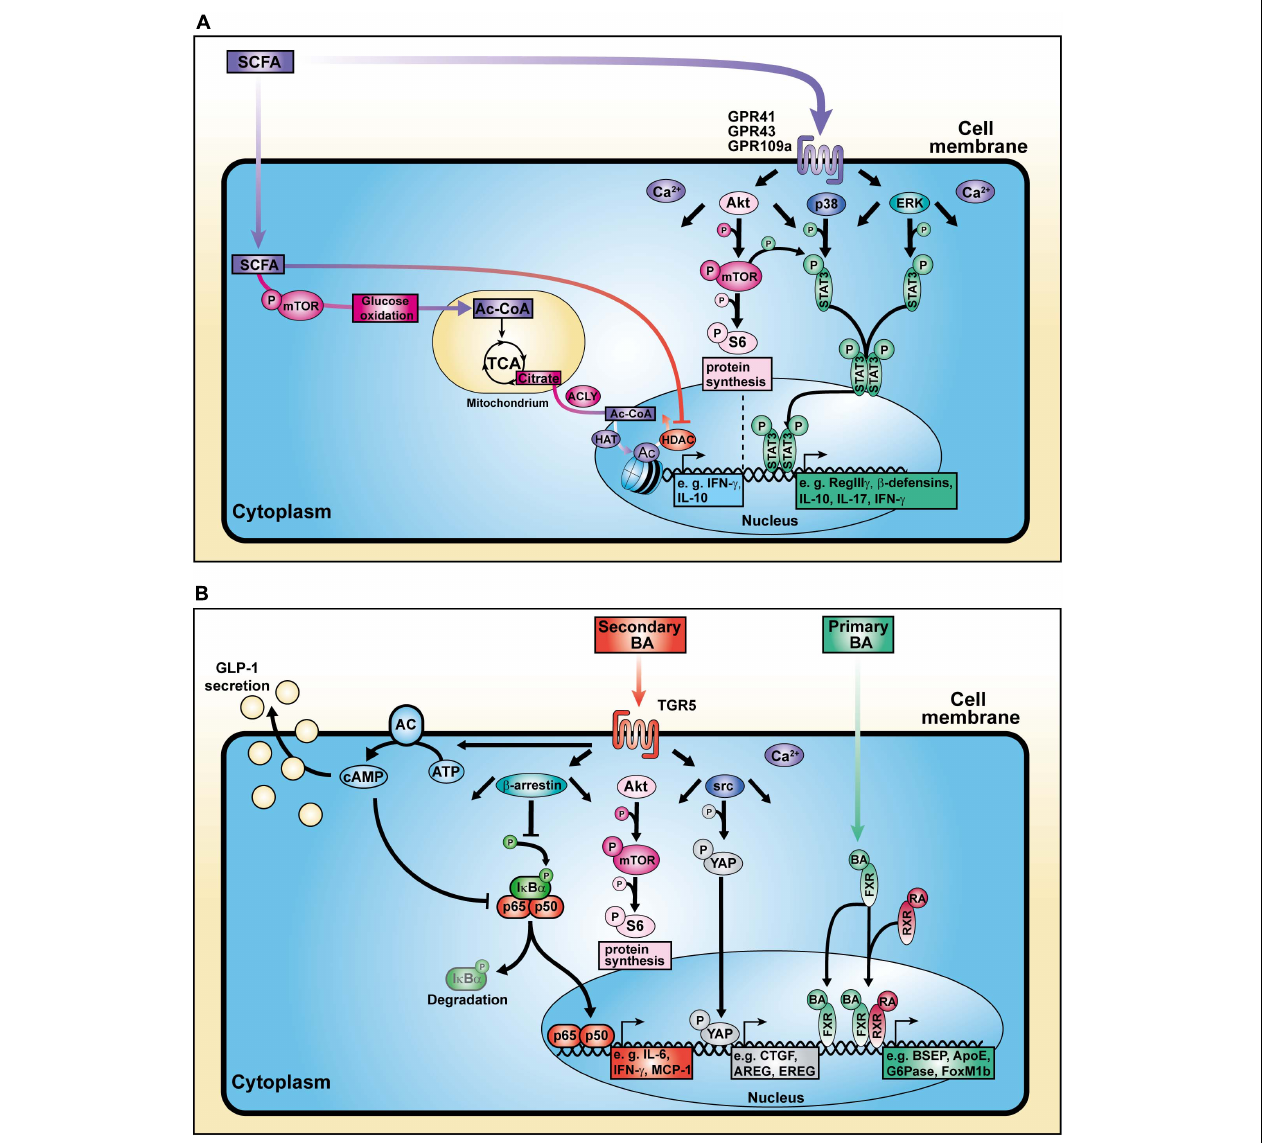
FIGURE 2 | Cellular mechanisms of action of SCFAs and BAs. (A) SCFAs influence cell signaling, metabolic activity, and histone modification. (B) BAs bind to surface and nuclear